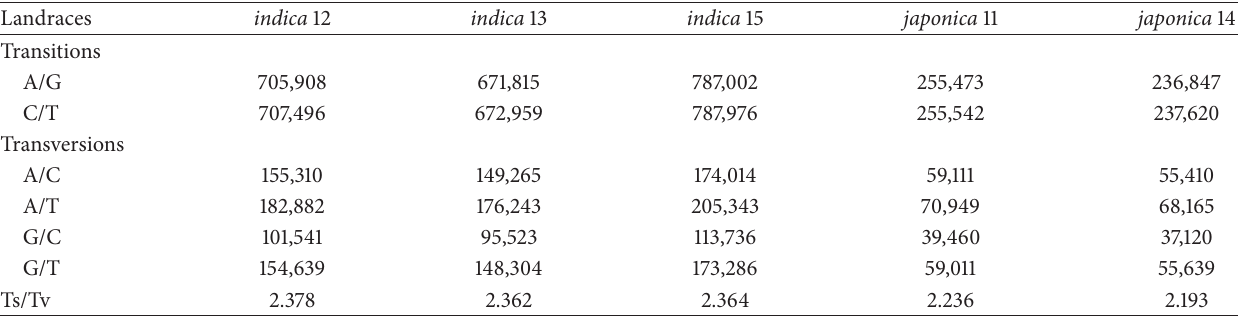
Table 4: Base changes in five rice